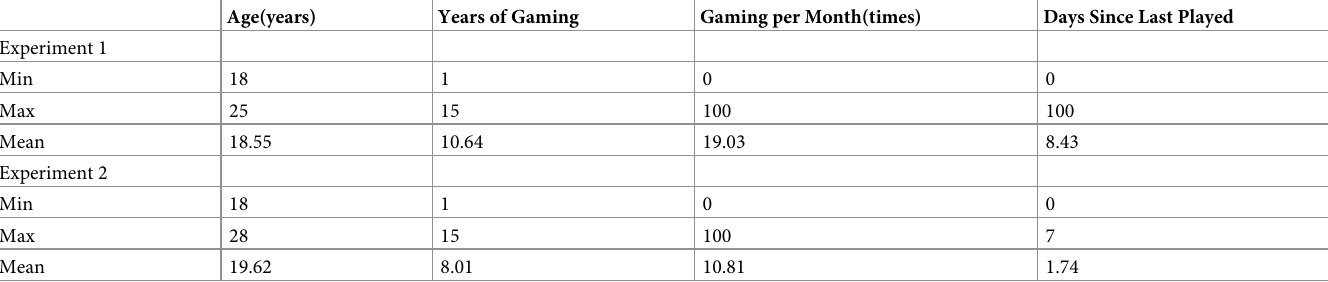
Table 3. Descriptive statistics for predictor variables in mixed logit analyses for gamers in experiment 1 and 2.